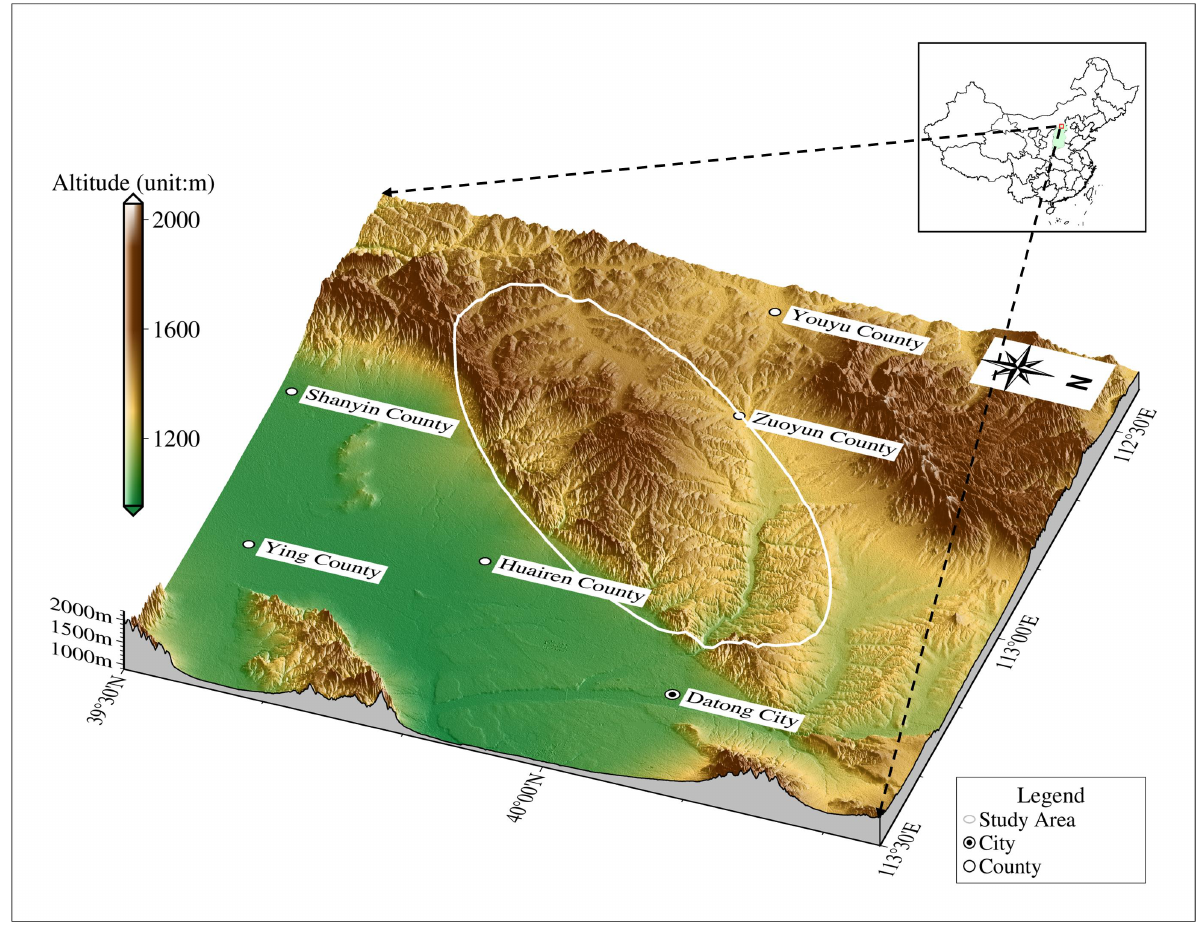
Figure 3. The location and altitude of the study